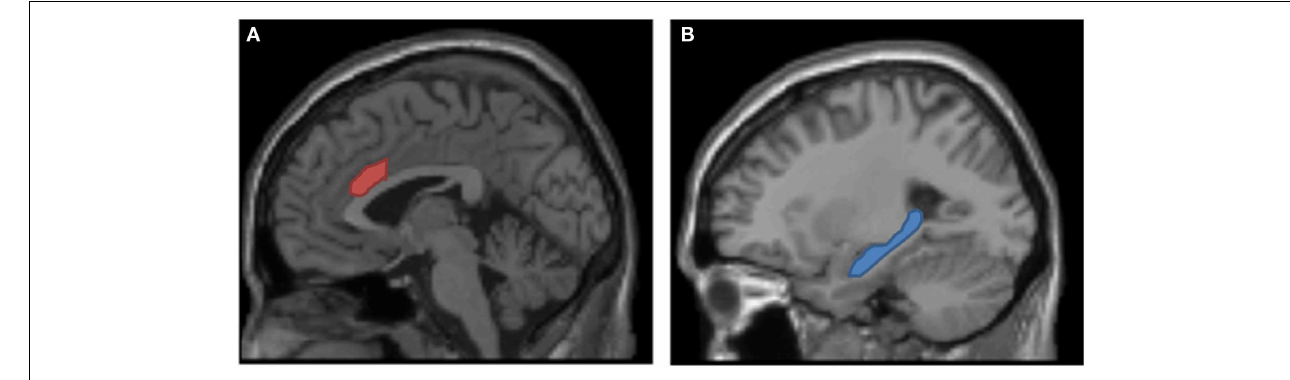
memory-related structures not depicted here) are required for episodic binding and the reactivation of the episodic context (cf. Meier et al.,